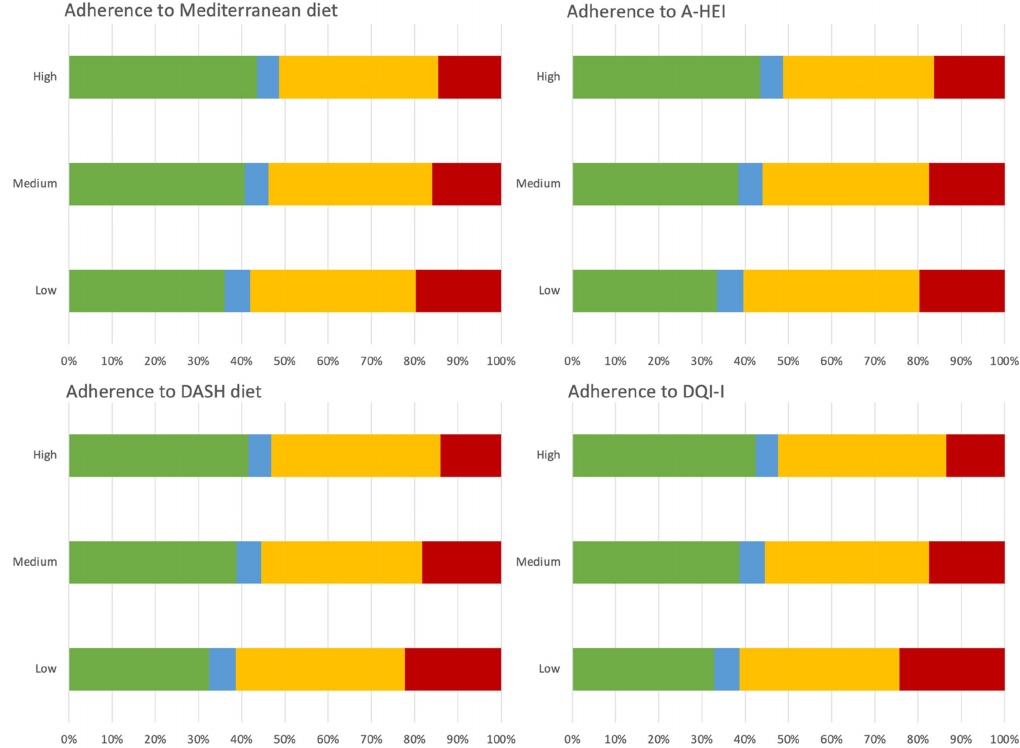
Figure 3. Percent distribution of food group consumption by level of processing across level of adherence to selected a ‐ priori defined healthy dietary patterns. Green color stands for unprocessed/minimally processed foods; Blue color stands for processed culinary ingredients; yellow color stands for processed foods; red color stands for ultra ‐ processed foods.